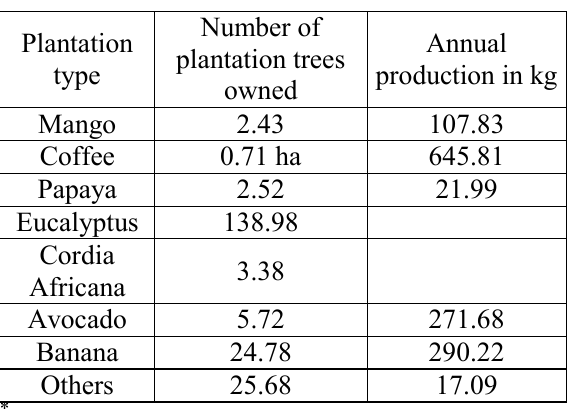
Table 1. Plantations and annual